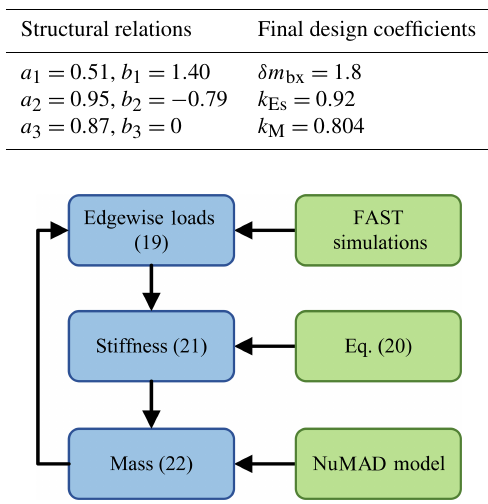
Figure 11. The relationship between blade mass, edgewise loads, and edgewise stiffness, as well how each value was